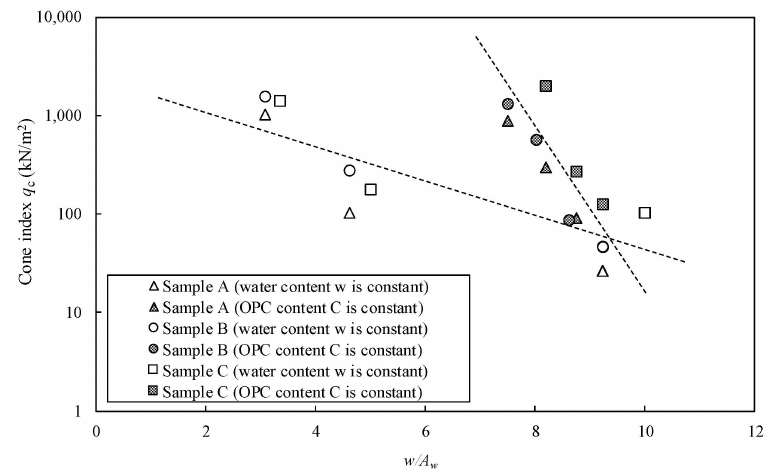
Figure 8. Cone index ( q c ) vs. w / A w ratio of clays stabilized by OPC in three types of Kumamoto